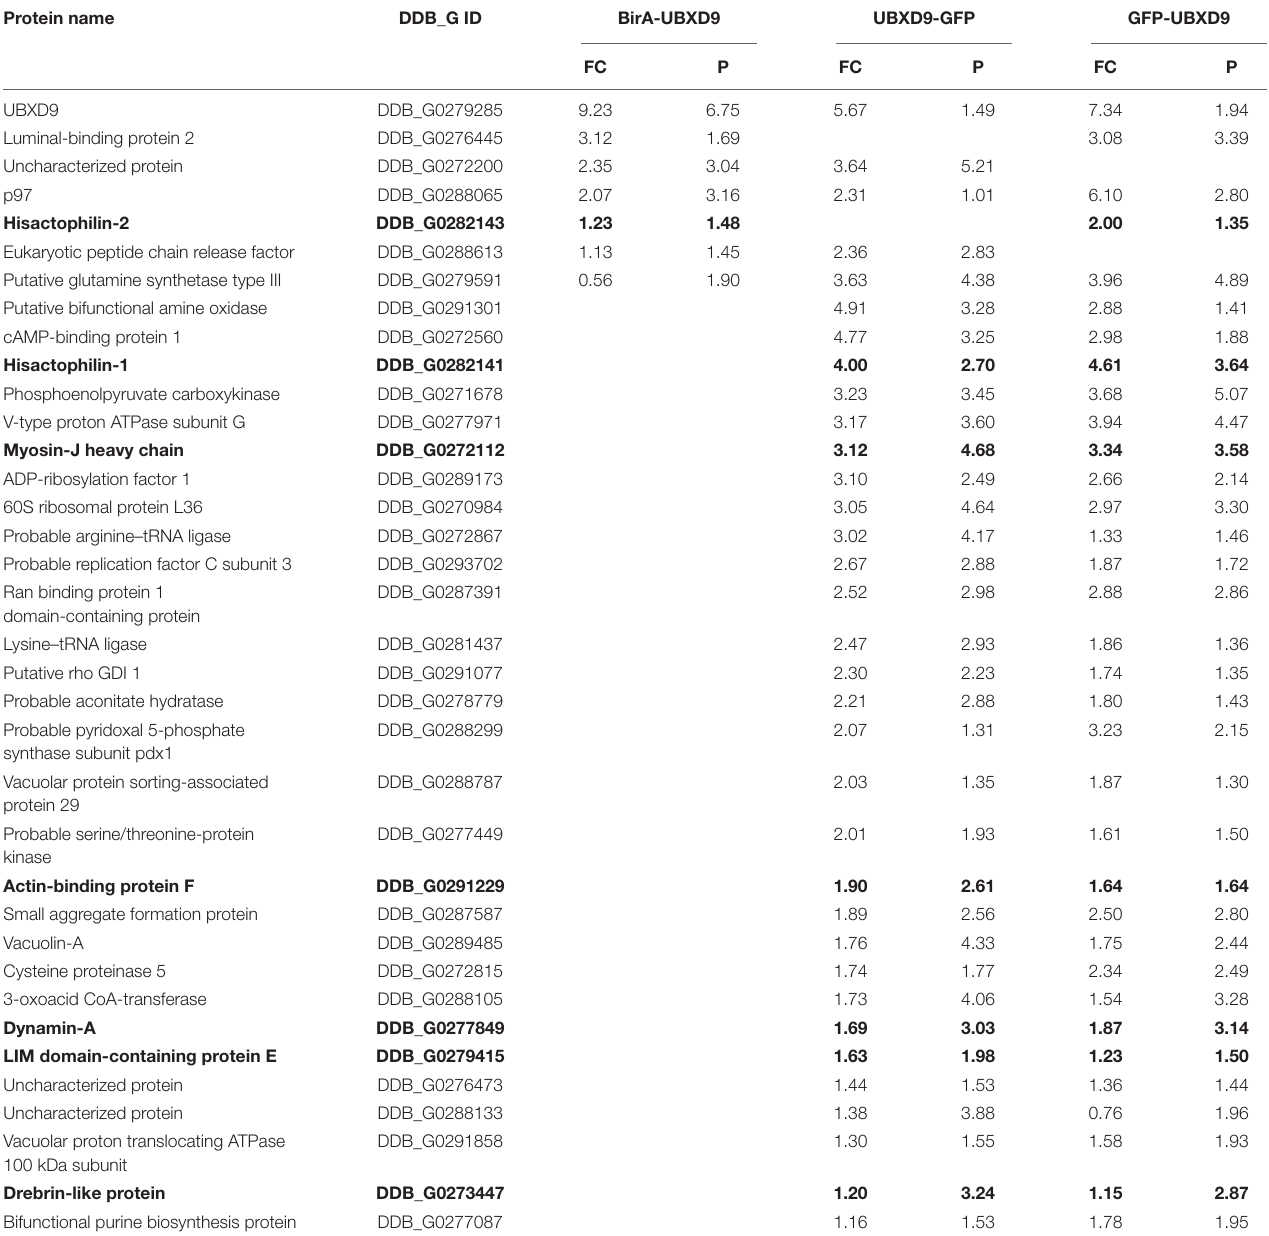
TABLE 2 | List of putative interacting proteins, which were identified in at least two different approaches. Protein